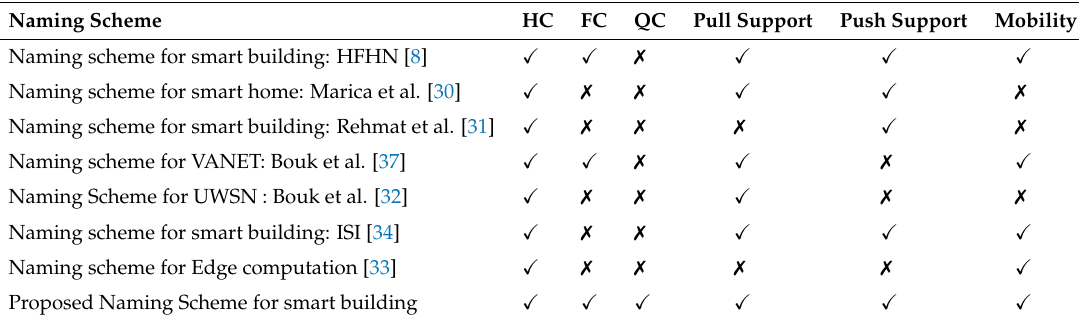
Table 1. Description of Packet